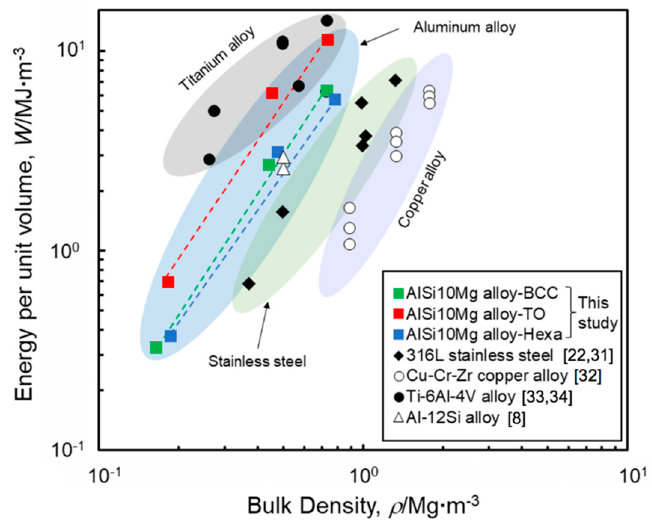
Figure 16. Relationship between energy per unit volume and bulk density of AlSi10Mg lattice structures. For comparison, the results of various lattice structures consisting of different materials are also shown in the Figure.